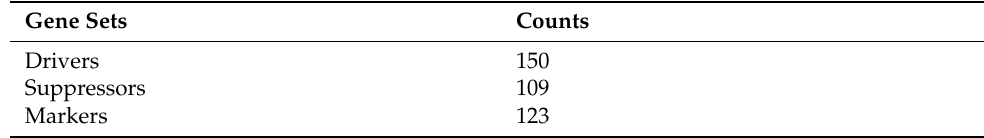
Table 1. Ferroptosis-related gene sets achieved from